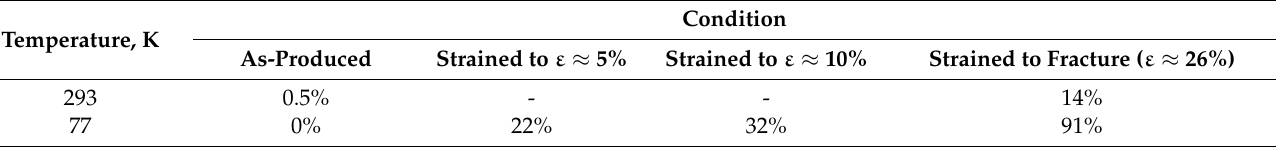
Table 5. Volume fraction of the bcc phase depending on the condition of the alloy.